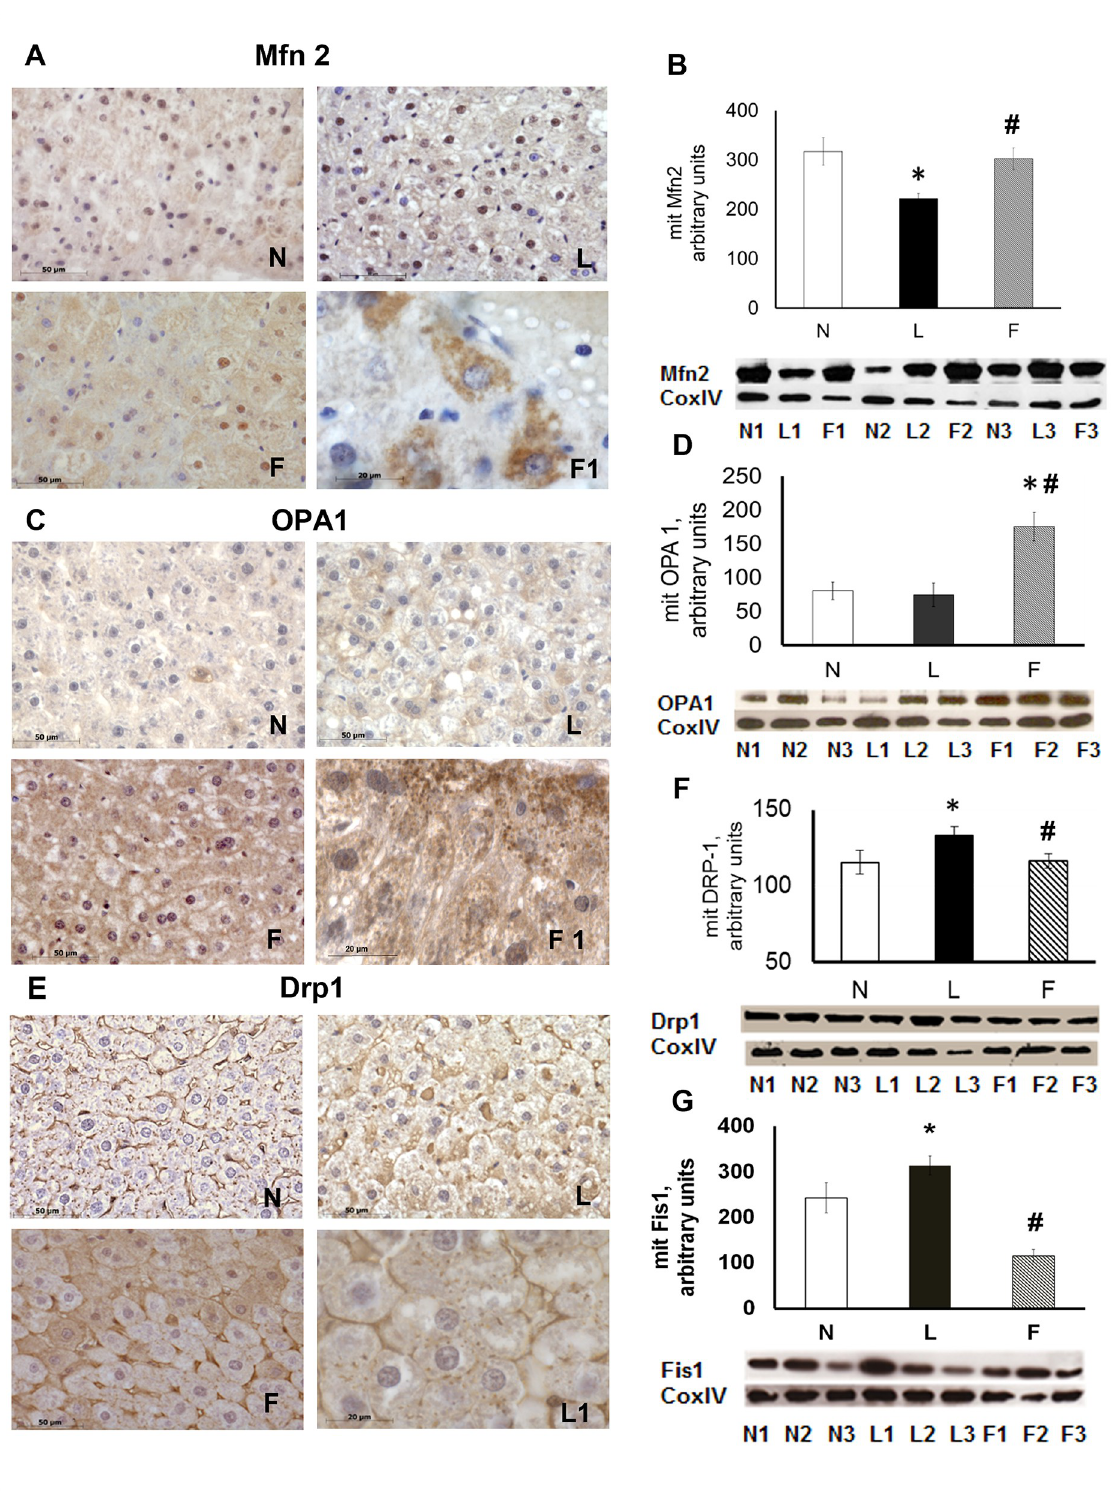
Fig 4. Proteins relevant to mitochondrial dynamics. ( A ), Immunohistochemical reaction and ( B ), immunoblot for Mfn2. ( C ), Immunohistochemical reaction and ( D ), immunoblot for OPA1. ( E ), Immunohistochemical reaction and ( F ), immunoblot for Drp1. ( G ), Immunoblot for Fis1. ( B ), ( D ), ( F ) and ( G ), Densitometric analysis data shown as means ± SE. � P < 0.05 vs. N rats. #P < 0.05 vs. L rats. For all immunoblots, representative blots are shown for each protein of interest. The intensities of the bands were normalised to that of Cox IV.